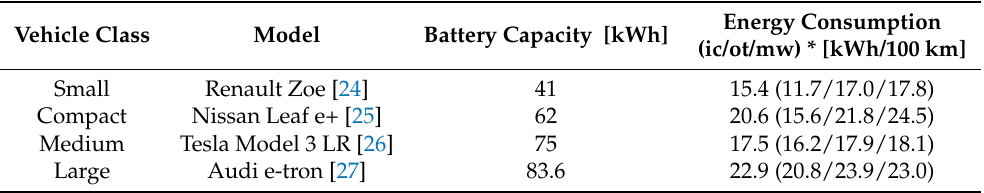
Table 3. Vehicle Attributes. Vehicle